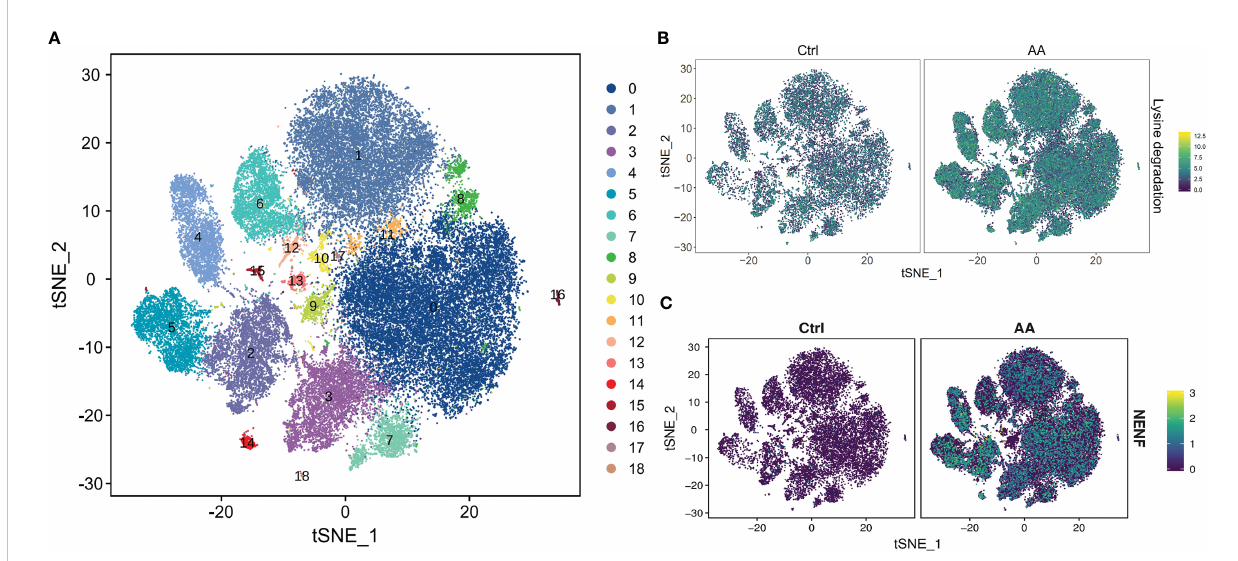
FIGURE 3 scRNA-seq revealed metabolic differences in AA. t-SNE plot of all cells representing the cell clusters analyzed by scRNA-seq. Each dot represents a single cell; each color corresponds to one cluster (A) . t-SNE plot showing the metabolism differences of lysine degradation between AA patients and healthy donors. Colors indicate logarithmic-transformed P values (B) . t-SNE plot showing the signi fi cantly expressed gene NENF in AA patients compared with those in healthy donors (C)